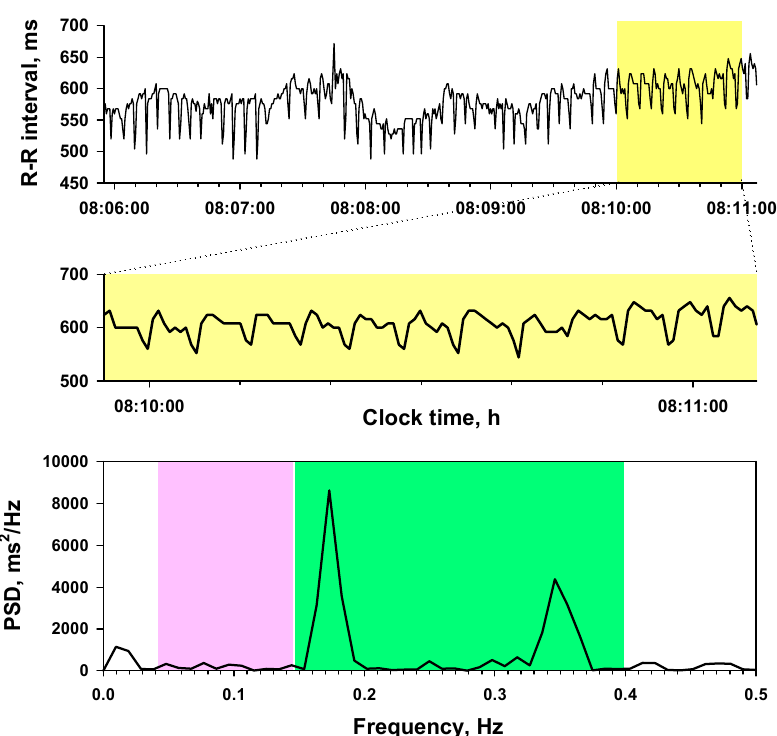
Figure 5. R-R interval trend grams and power spectrum of the same case as Figure 4. HRF causes frequent inflection points in R-R interval (upper panel) and forms a spectral peak often in HF band (lower panel).